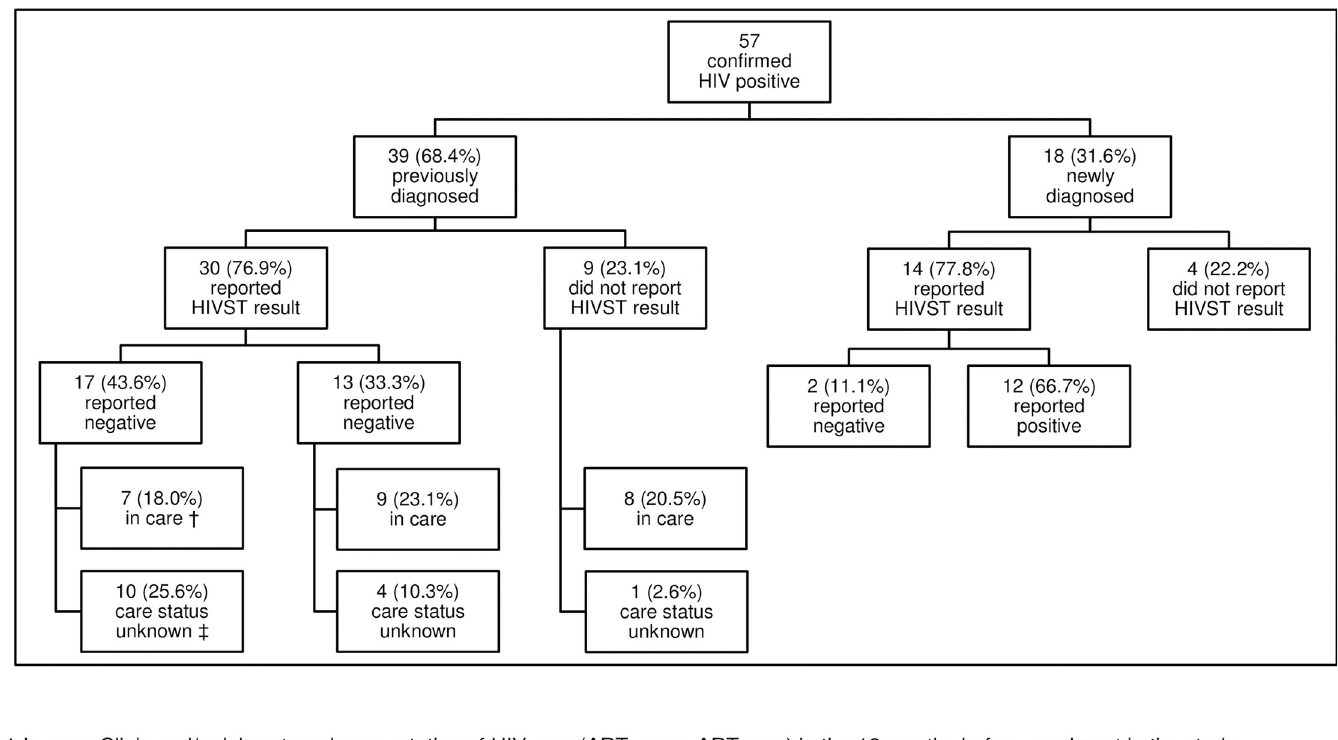
Fig 2. Flow diagram for HIV positive participants.